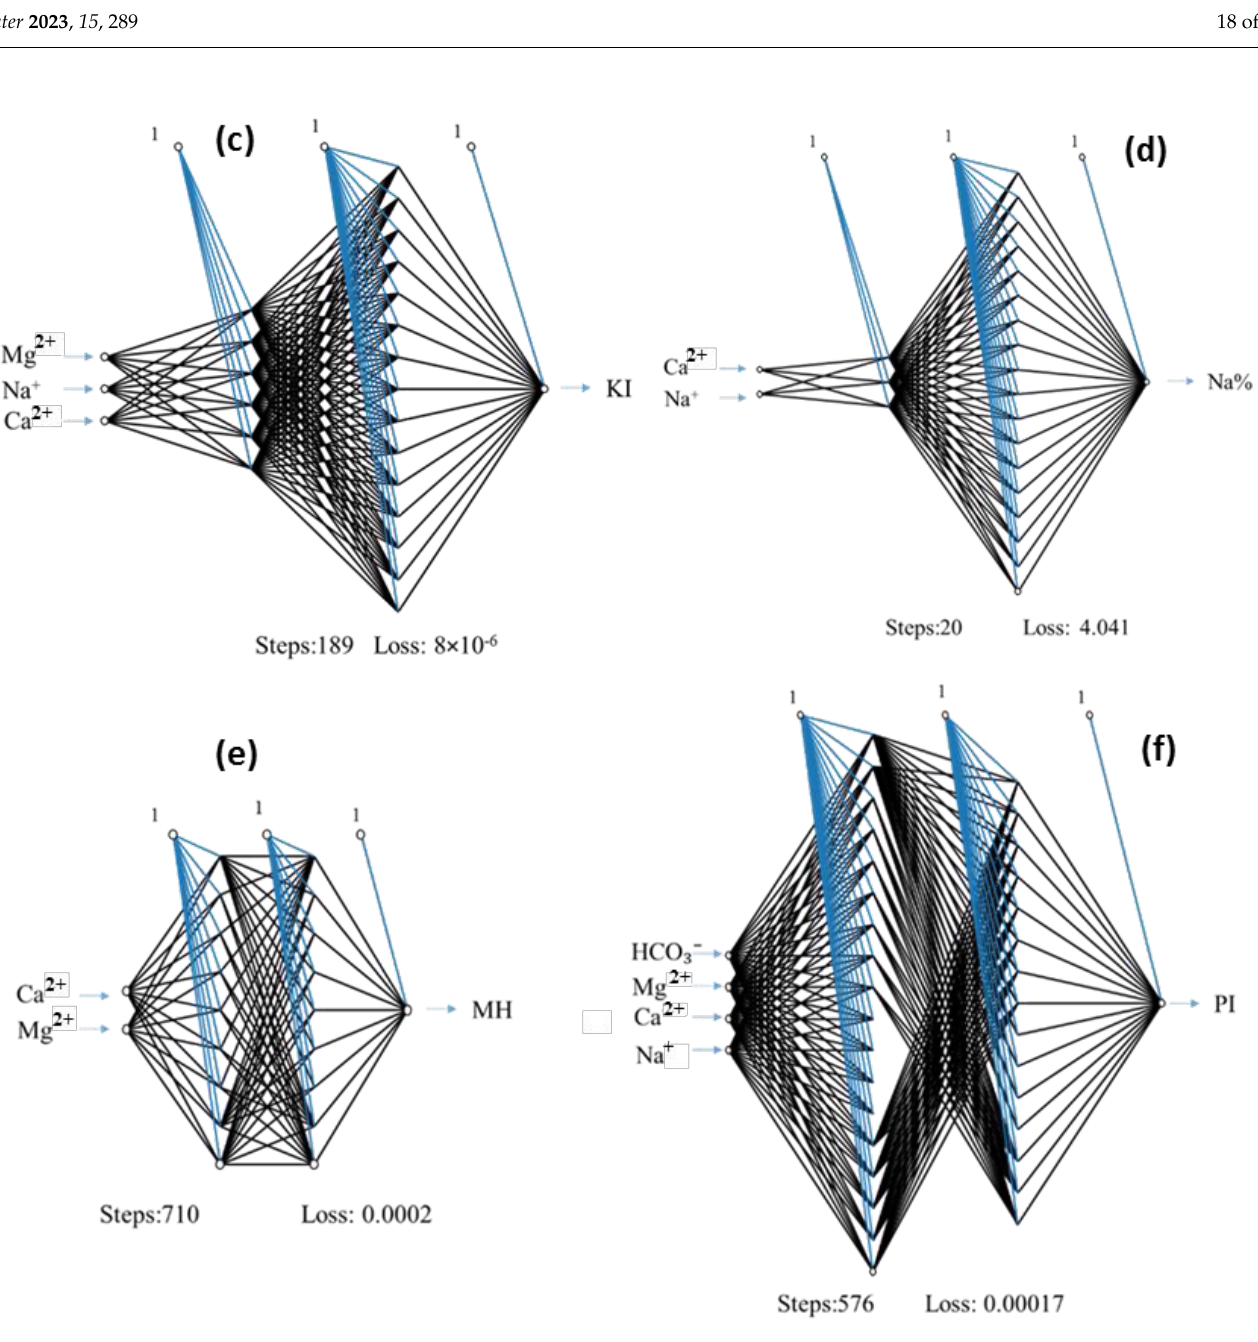
Figure 9. The ideal ANN architecture for detecting spatial groundwater quality variations: ( a ) IWQI, ( b ) SAR, ( c ) KI, ( d ) Na%, ( e ) MH, and ( f ) PI.